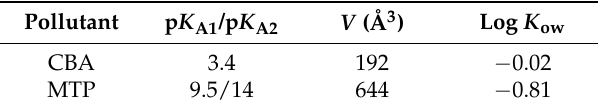
Table 1. Physicochemical characteristics of the adsorbates at pH